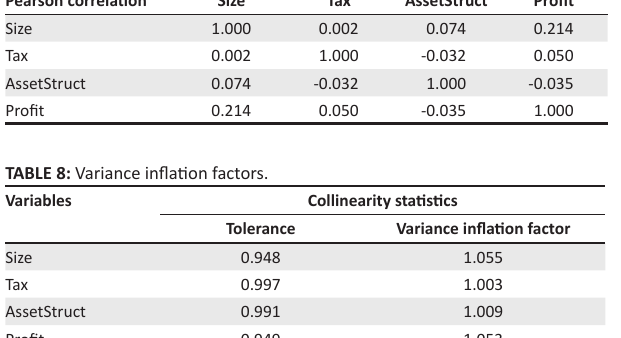
TABLE 7: Pearson correlations. Pearson correlation